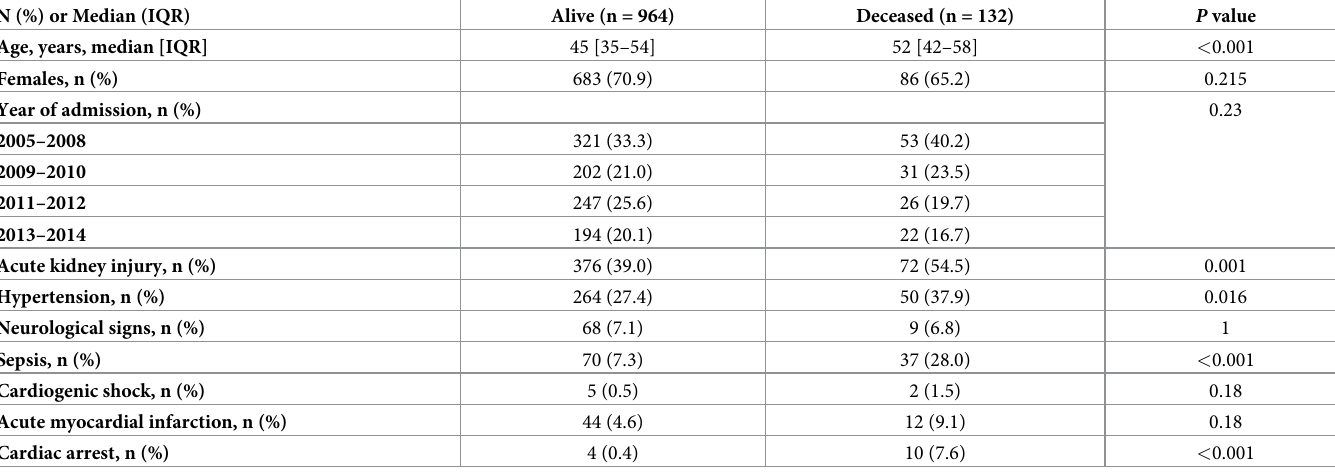
Table 1. Patients’ characteristics and diagnoses associated with